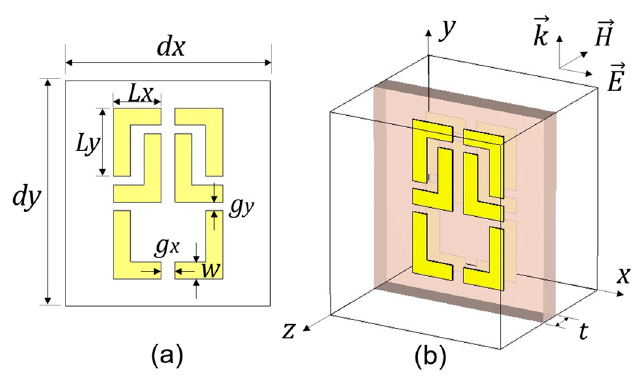
Figure 5. Schematic of L-shaped unit cell: ( a ) top view, and ( b ) 3D view.